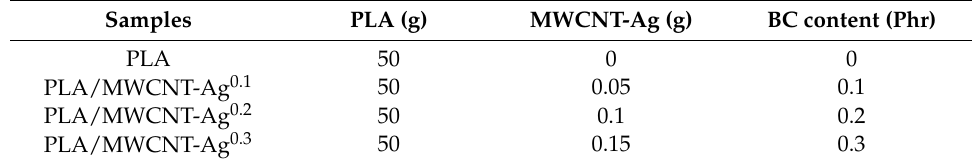
Table 1. Designations and compositions of the poly(lactic acid) (PLA)/MWCNT-Ag nanocomposites. Samples PLA